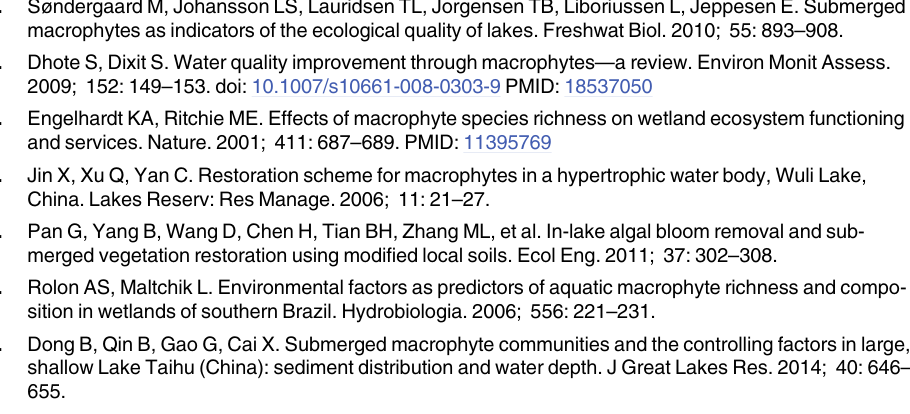
Fig 3. Effects of propagule pressure and water depth on the per individual growth of each species of the four submerged macrophytes. Mean values ( ± SE) are